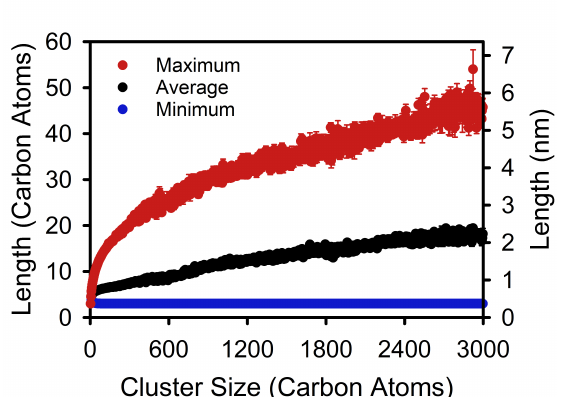
Figure 2. Variation in minimum, maximum, and average stem lengths as a function of crystal cluster size. Each data point corresponds to a size-dependent conditional average for a given nucleus size. For example, the maximum (red) point at 600 carbon atoms indicates the average maximum stem length of clusters corresponding to 600 carbon atoms. The error bars indicate standard errors, which are smaller than the symbol size for the minimum and average data.